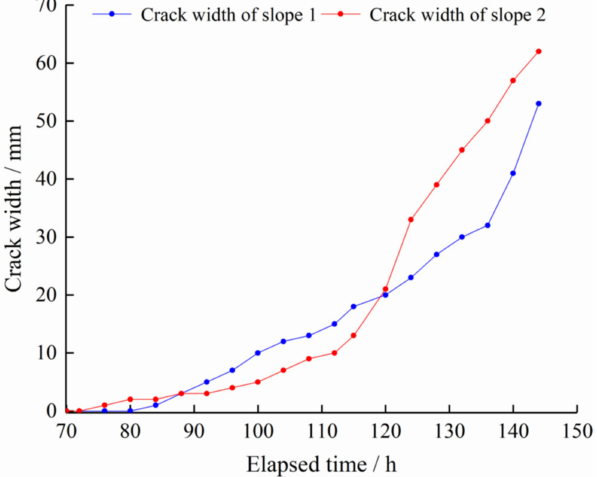
Figure 9. Curves of crack width with time in test slopes.